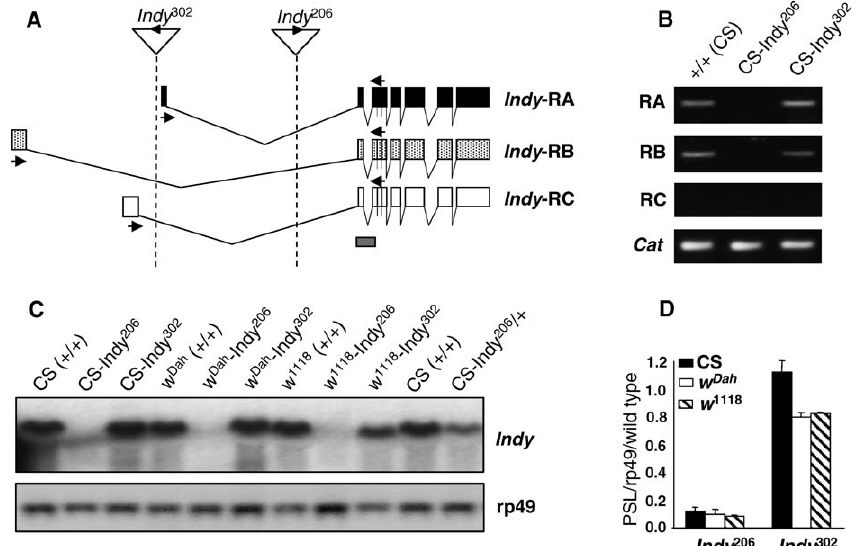
Figure 3. Alternative Transcripts and Gene Expression in Indy Mutants A) Indy encodes three putative transcripts (RA, RB, and RC) that differ in their ultimate 5 9 -exons. The insertion sites and orientations of Indy 206 and Indy 302 are shown (triangles and dashed line). The isoform-specific upstream primers (IndyRA-51, IndyRB-51, and IndyRC-51) and a downstream common region primer (IndyR-31) are indicated as arrows. Common region probe used for northern analysis (C) is indicated as grey box. B) cDNAs from the homozygous Indy mutants and CS ( þ / þ ) control analyzed by isoform-specific PCR. Expression of all isoforms was abolished by Indy 206 mutation. Indy 302 line expressed both isoforms present in the wild-type cDNA. There was no evidence for isoform RC whereas the control (Catalase) could be amplified from all cDNA samples. C) Expression analysis of Indy mutants in different genetic backgrounds. Northern hybridization from wild type ( þ / þ ), Indy 206 , and Indy 302 homozygotes in CS, w Dah , and w 1118 genetic background. The two last lanes show CS ( þ / þ ) compared to intermediate Indy 206 / þ heterozygous expression. Ribosomal protein rp49 hybridization is shown for loading. D) Phosphorimager quantification of the northern data. The graph shows mean (and standard error) of two separate hybridizations normalized by rp49 and is shown as relative 32 P-stimulated luminescence compared with CS, w Dah , or w 1118 flies. upper left panel). We also analysed the mutants (and wild- type controls) in the two other genetic backgrounds used, and found no signs of infection in either the w Dah (Figure 5A) or w 1118 (unpublished data) backgrounds.